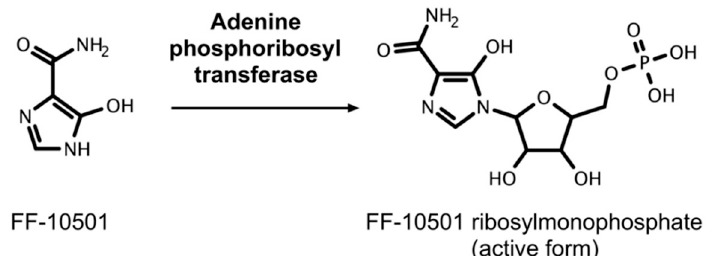
Figure 8. Activation of FF-10501. FF-10501 is metabolized intracellularly to its active form, FF-10501 ribosylmonophosphate (RMP), which inhibits IMPDH.